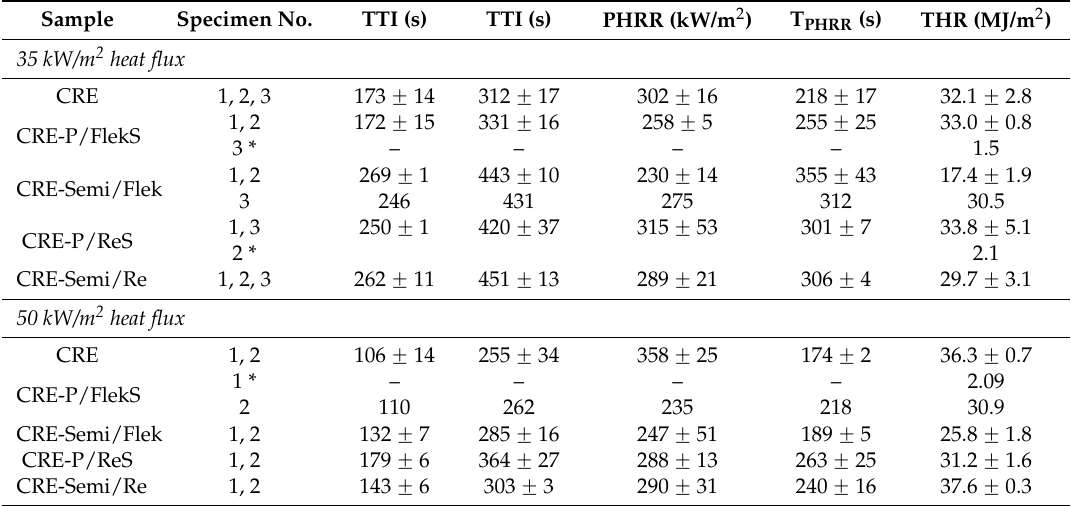
Table 2. Cone calorimetric data for control and all coated samples at 35 and 50 kW/m 2 heat flux. Sample Specimen No. TTI